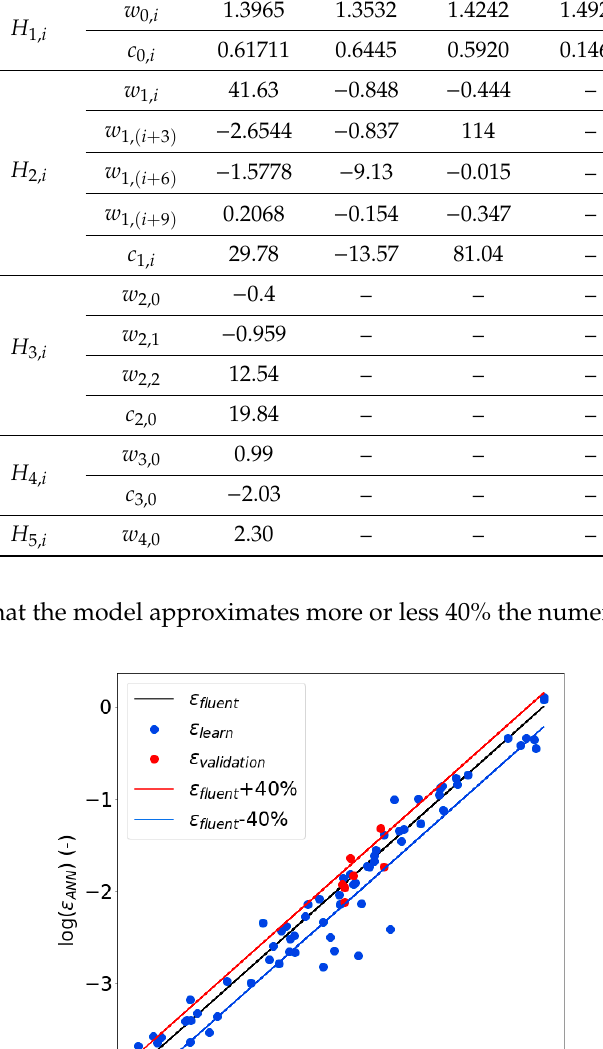
Table 2. Parameters for Equations (25)–(29).